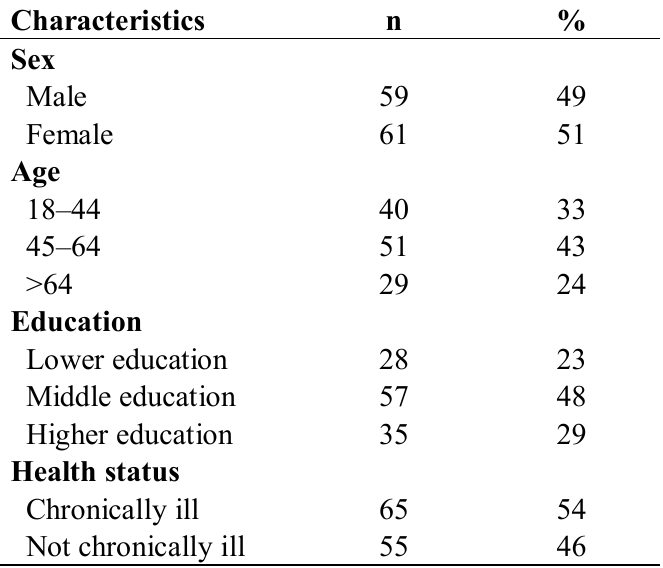
Table 4. Descriptive characteristics of